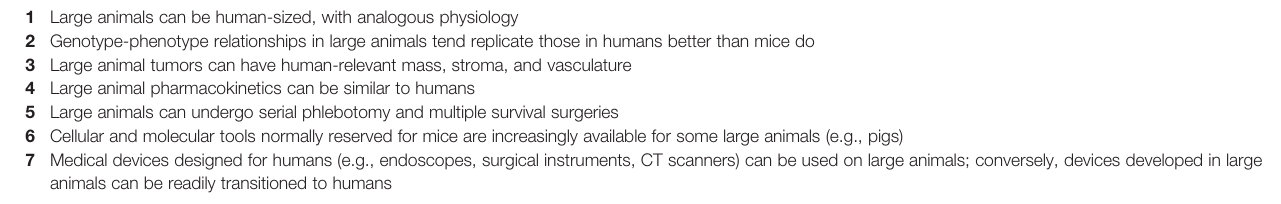
TABLE 1 | Advantages of large animal cancer